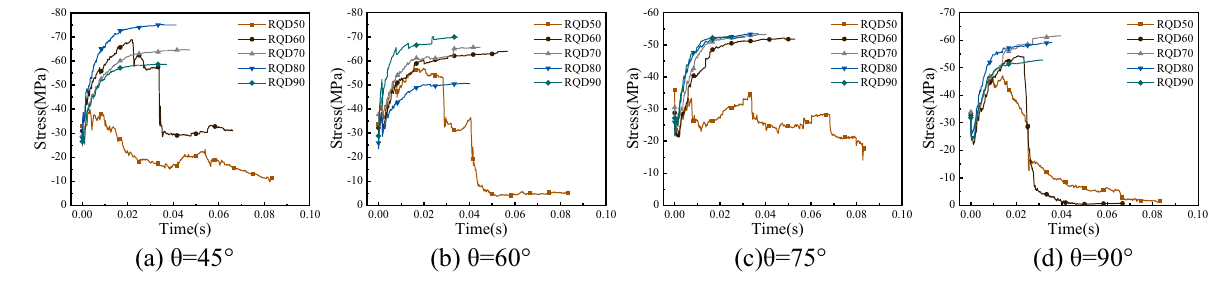
Fig. 13 Tangential stress with different RQD values in the same inclined angles of joints( σ